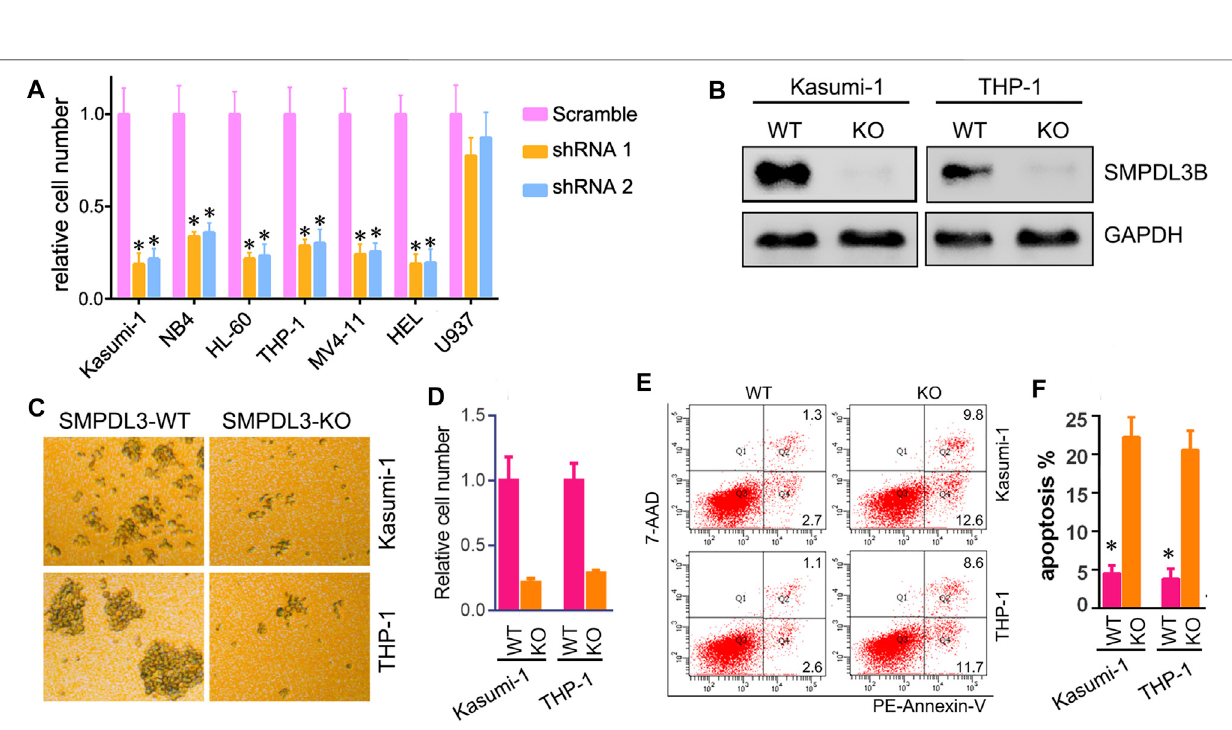
FIGURE 3 | The expression of SMPDL3B in AML subtypes and correlation with overall survival of the patients. The AML patients were divided into the indicated subgroups ( (A) : age < 60, (B) : age ≥ 60; (C) : cytogenetic favorable, (D) : cytogenetic intermediate, (E) : cytogenetic poor; (F) : IDH1 positive, and (G) : IDH1 negative) according to the age, cytogenetics risk, and IDH1 expression status, respectively. The Kaplan – Meier overall survival in the indicated subgroups of AML patients with SMPDL3B low and SMPDL3B high expression is plotted respectively. p value was calculated by log-rank test.